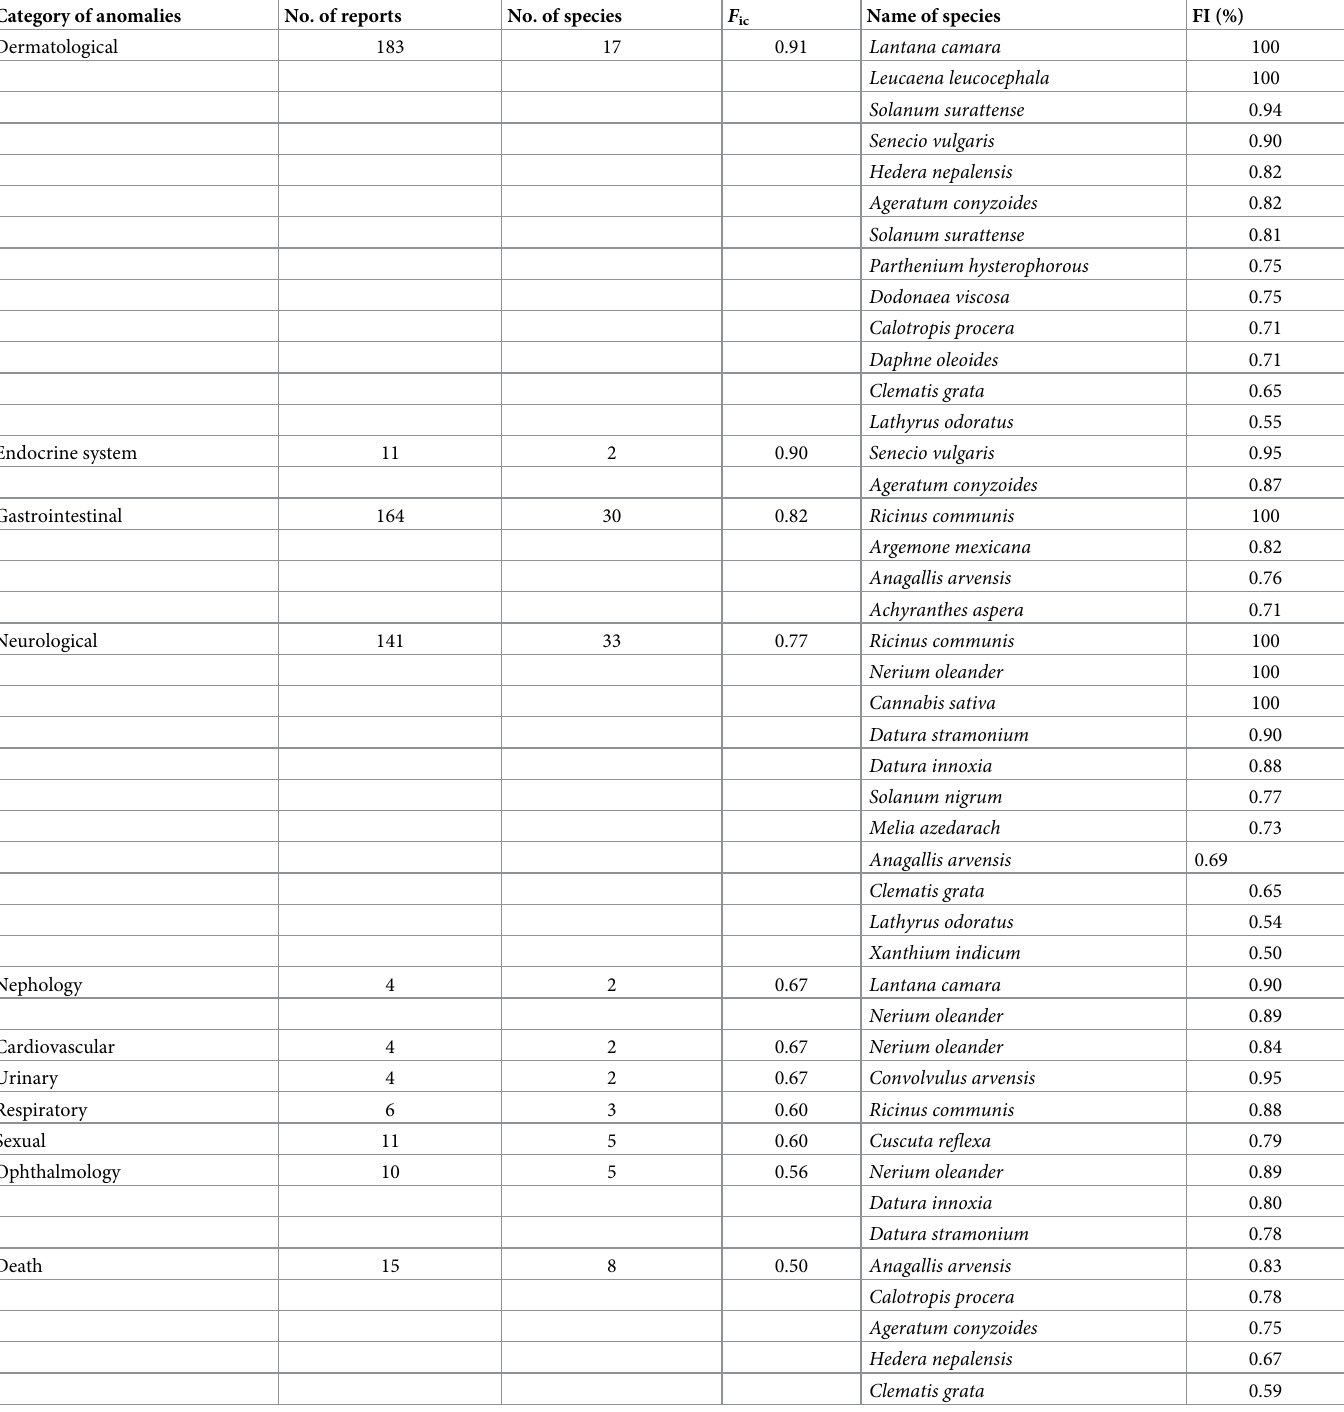
Table 3. Category of anomalies (Heinrich et al., 1998) [43] and their factor informant consensus ( F ic ) and fidelity level (Fl %) of poisonous species. Category of